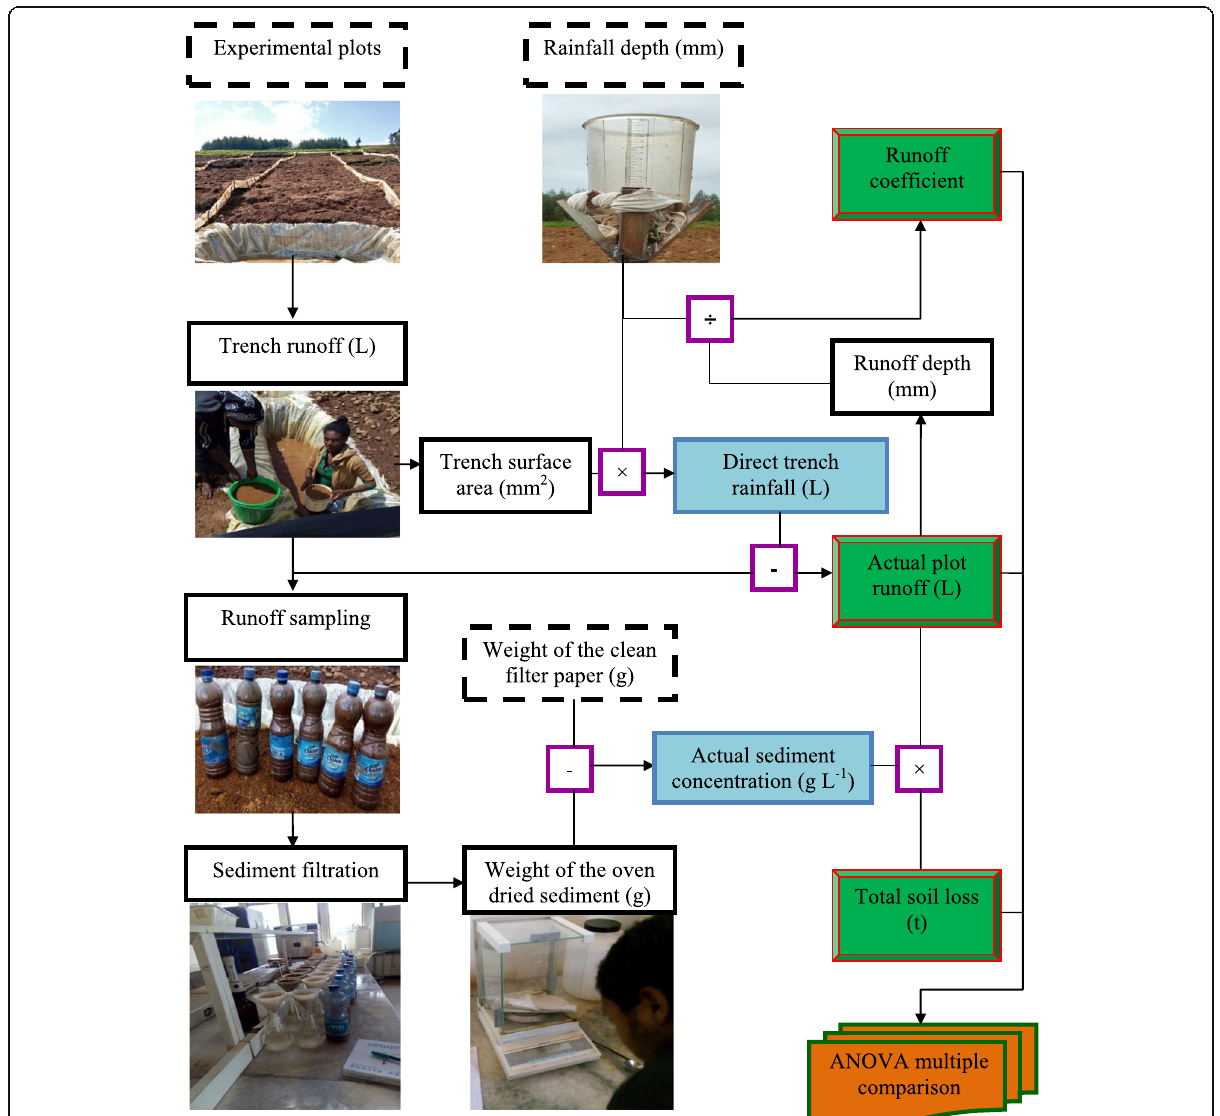
Fig. 3 A simplified methodological framework employed to study the effect of new and old soil bund treatment on runoff, runoff coefficient, and soil loss against the non-treated